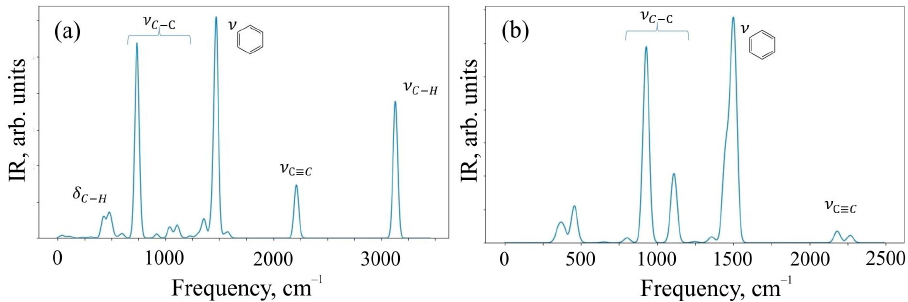
Figure 5. IR spectra of ( a ) O1 oligomer and ( b ) 6,6,12-graphyne crystal.